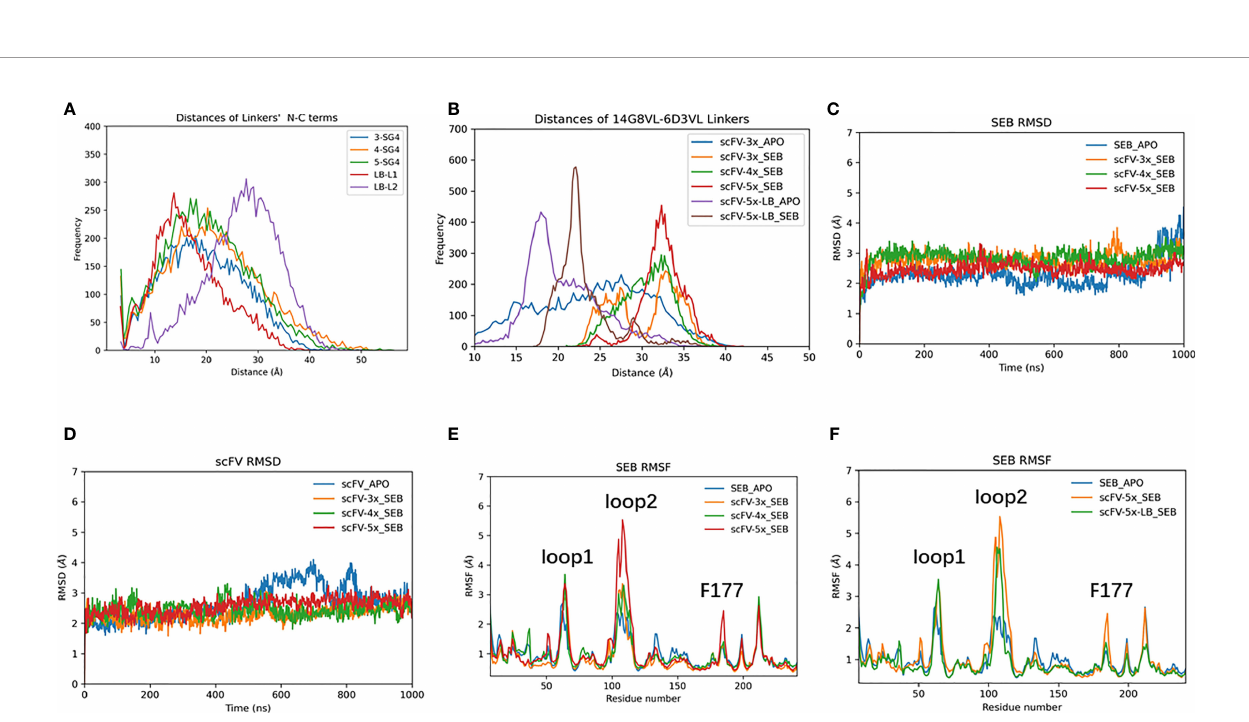
FIGURE 6 | The effects of connecting loop of scFV. (A) end-end distance distribution of isolated loop peptide in solution during 1000 ns MD simulations. (B) Comparable distance distribution of connecting loop within scFVs during 1000 ns MD simulations. (C) RMSD trajectories of SEB. (D) RMSD trajectories of scFV, which is average of RMSD of 14G8 and 6D3 VH/VL chains at each frame. (E, F) RMSF plots of SEB domain in different